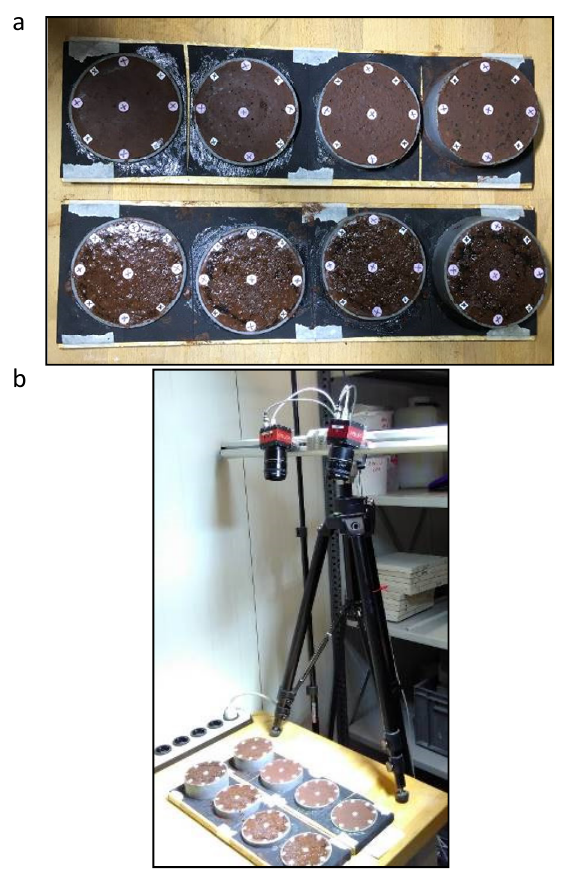
Figure 4. Very early shrinkage test: a) cylindrical specimens of mix W ‐ GPM (upper row), D ‐ GPM (lower row), b) stereo ‐ camera set